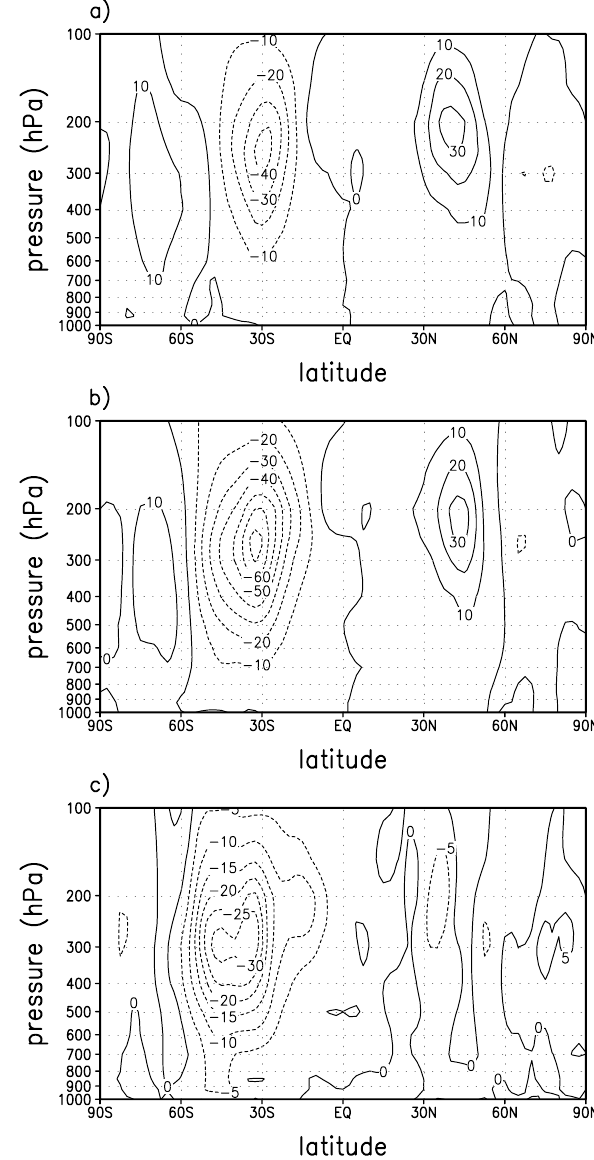
Fig. 8. Zonally-averaged eddy momentum flux for January: (a) 1995, (b) 1997, and (c) Difference (1997 minus 1995). Units, m − 1 K.